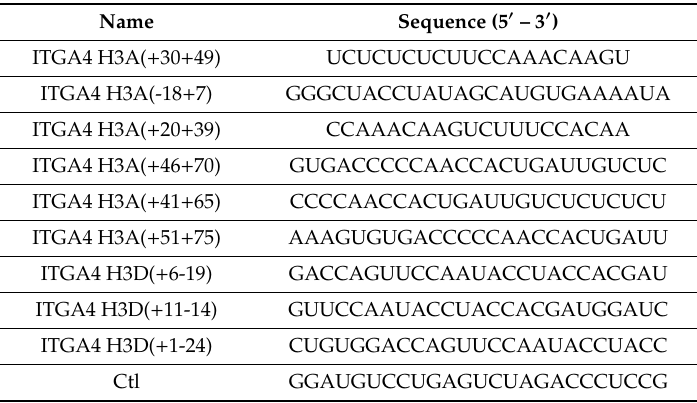
Table 2. List of AOs